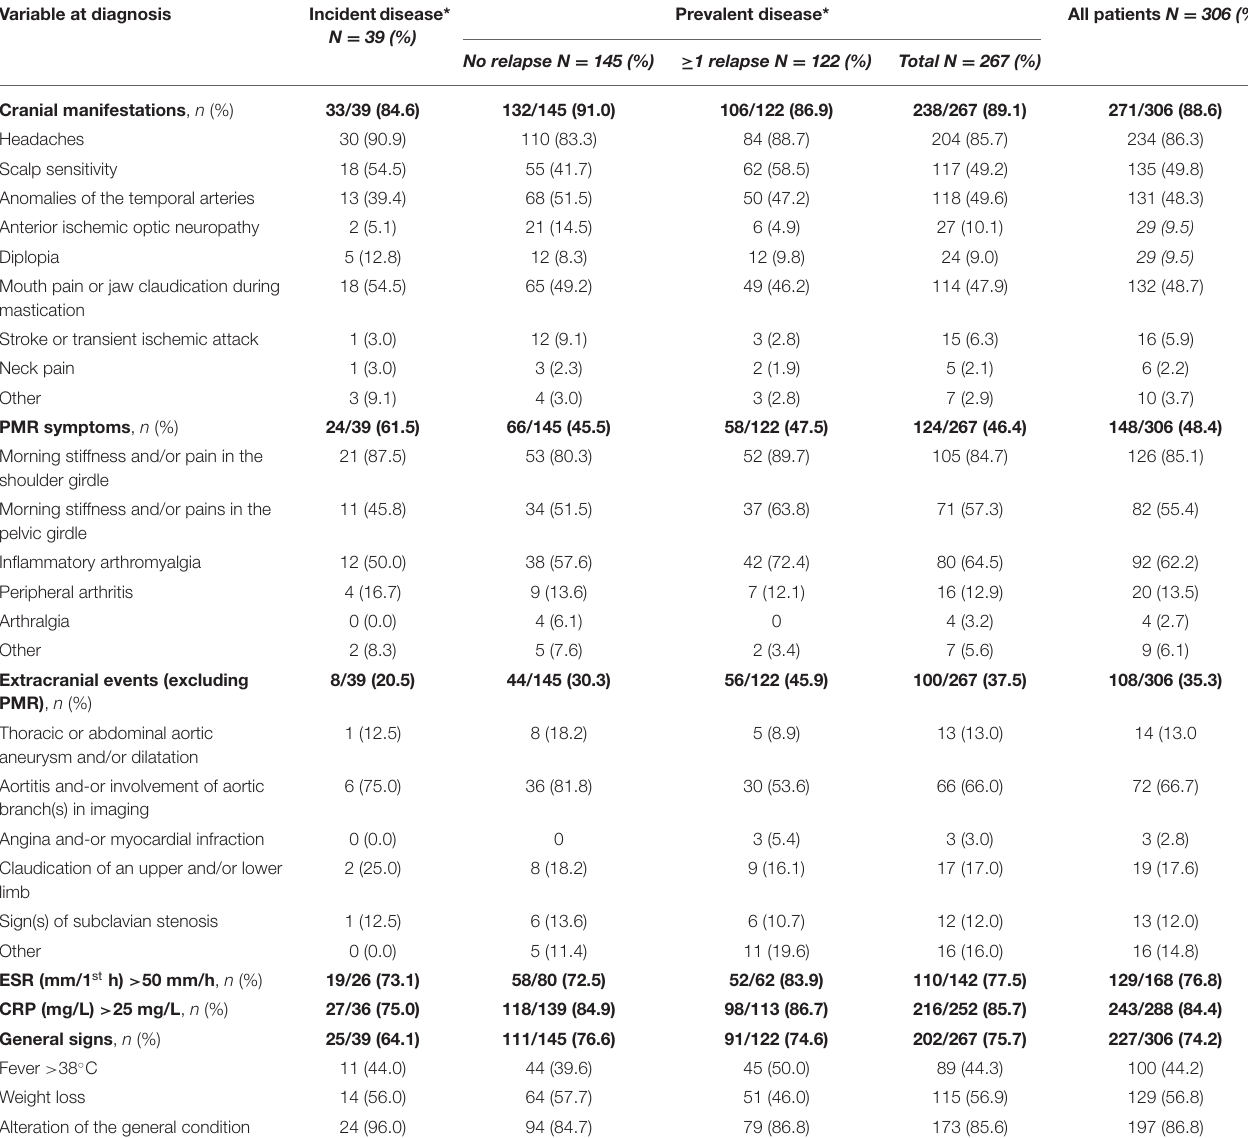
TABLE 2 | Initial presentation of giant cell arteritis.